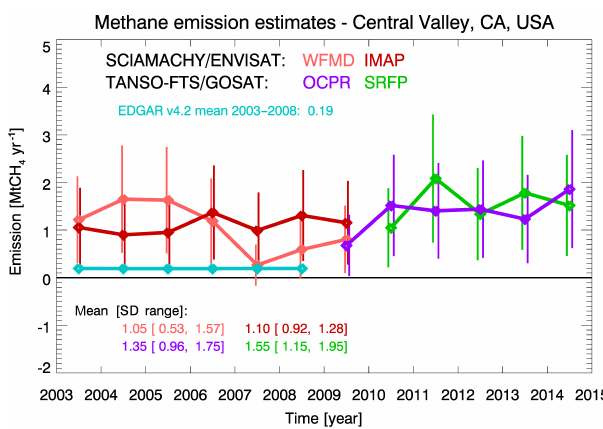
Figure 18. Methane emission estimates for Central Valley area in California, USA, as defined for this study (see Fig. 17 and Ta- ble 2). The blue line shows the EDGAR v4.2 (annual) anthro- pogenic methane emissions as computed for the Central Valley source